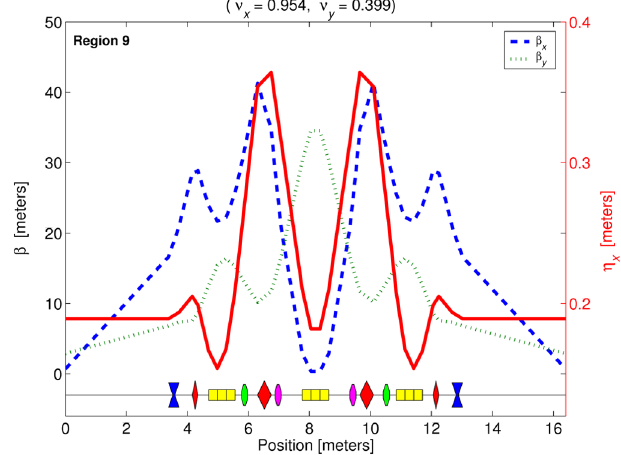
FIG. 10. (Color) Lattice of one of 12 ALS TBA sectors and associated lattice functions in region 9.